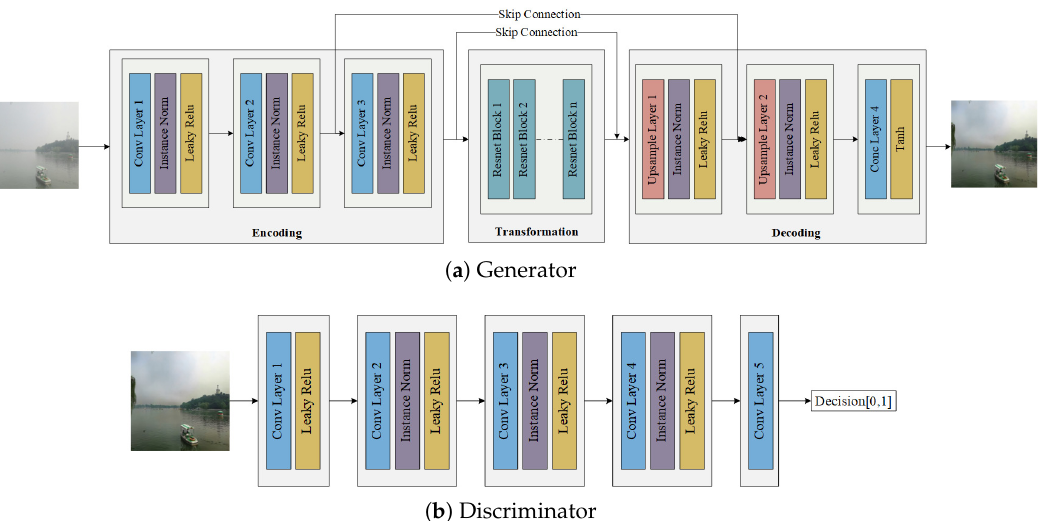
Figure 3. Architecture of our generator and discriminator. The generator consists of encoding, transformation, and decoding three